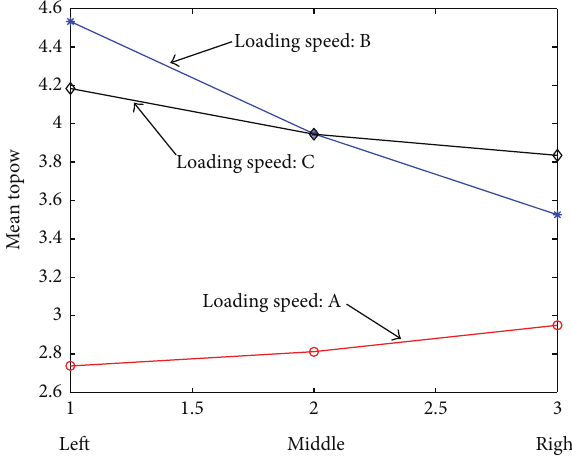
Figure 9: Modulus maxima and their positions of each layer high frequency coefficients with A1(R).